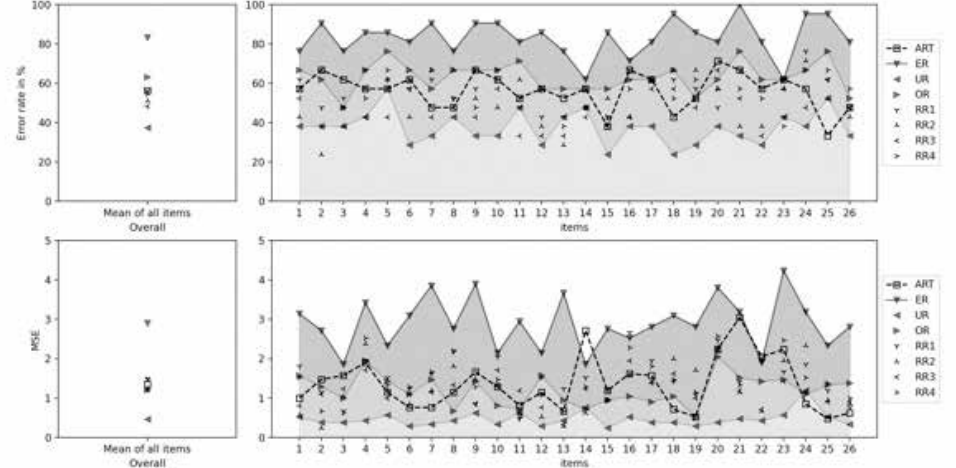
Error rate and MSE: Overall and for all each item‘s neural network